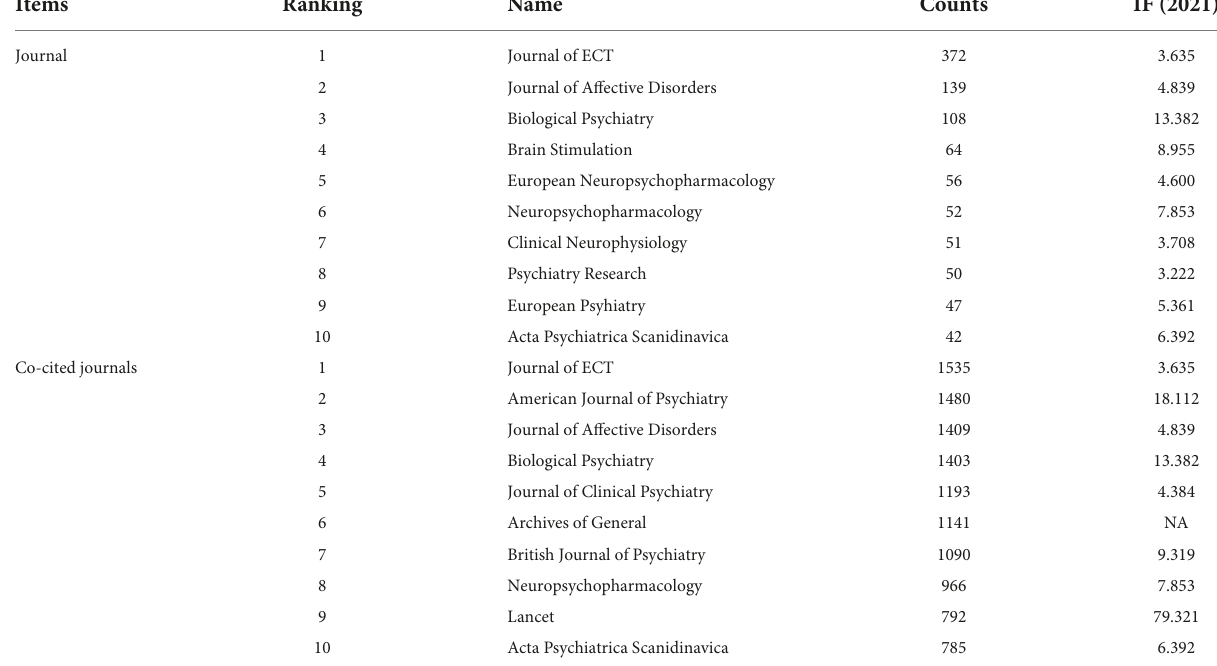
TABLE 2 Top 10 journals and co-cited